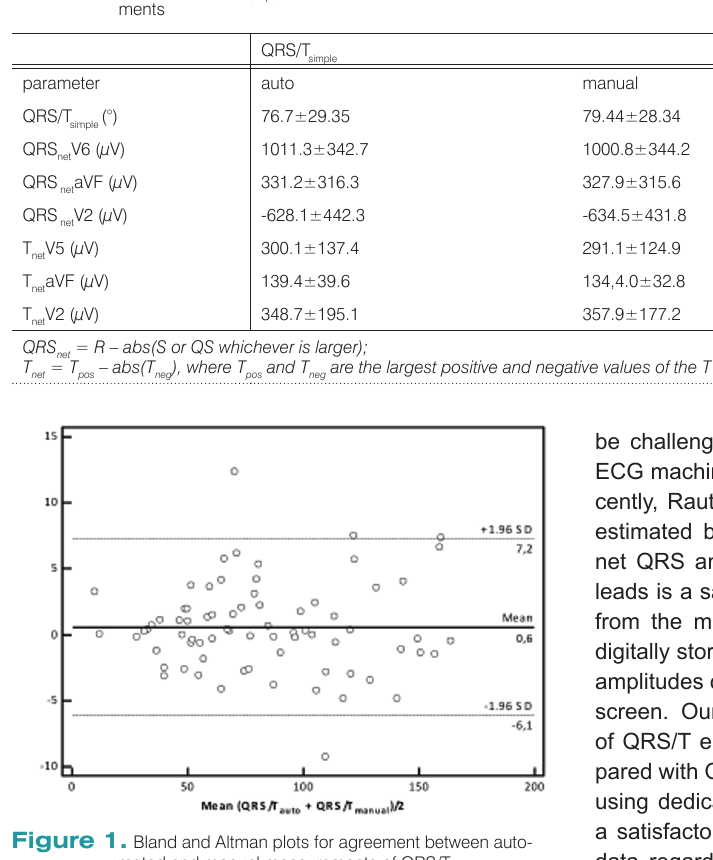
Table 2. Results of QRS/T